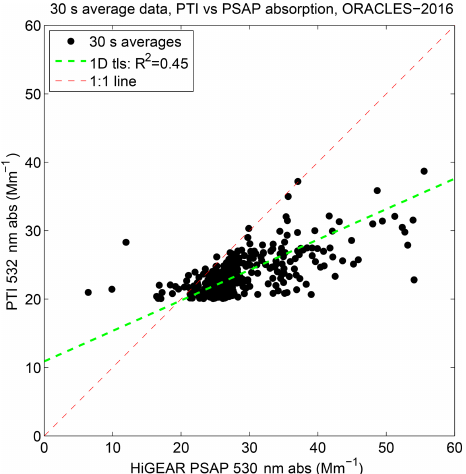
Figure A3. Comparison between PTI versus PSAP aerosol absorp- tion coefficient (at 532 and 530nm, respectively) for all available flight data. Lines show a 1 : 1 relationship (red dashed) and a total- least-squares fit (green dashed) through the data. The slope of the green line is 0.445 with an intercept of 10.9. There was no dis- cernible distinction in the fits or correlations between the two in- struments either between the in-plume leg and profile or by